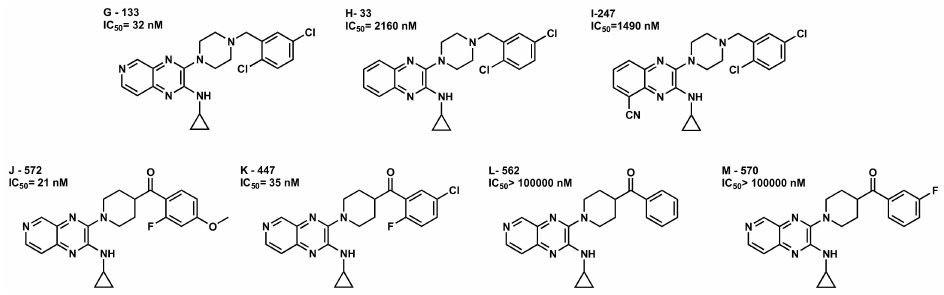
Figure 12. Other GPR6 modulators—Pyrazine analogs. The numbers next to the alphabetic letter for each compound come from Envoy Therapeutics, Inc. and Takeda Pharmaceutical Company